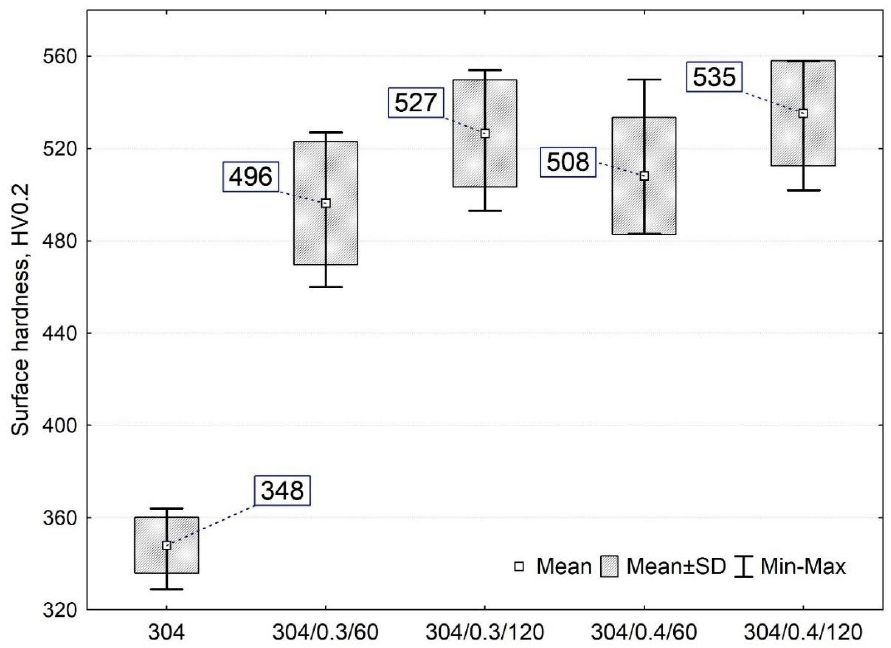
Figure 5. Surface hardness of unpenned (304) and shot peened samples.